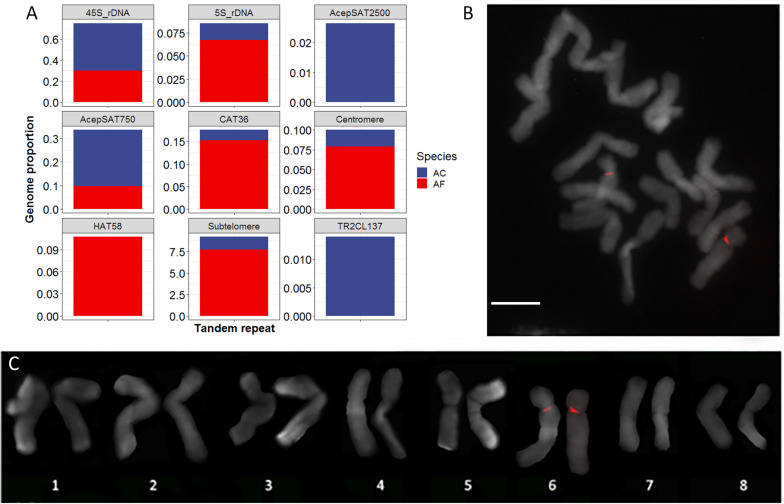
Tandem repeats of A. cepa and A. fistulosum genomes. (A) Genome proportion of known and new (TR2CL137) tandemly organized sequences in A. cepa (AC) and A. fistulosum (AF) genomes; (B) FISH with labeled TR2CL137 tandem repeat on A. cepa chromosomes (bar – 10 μm); (C) Karyotype of A. cepa chromosomes after FISH with labeled TR2CL137 repeat.